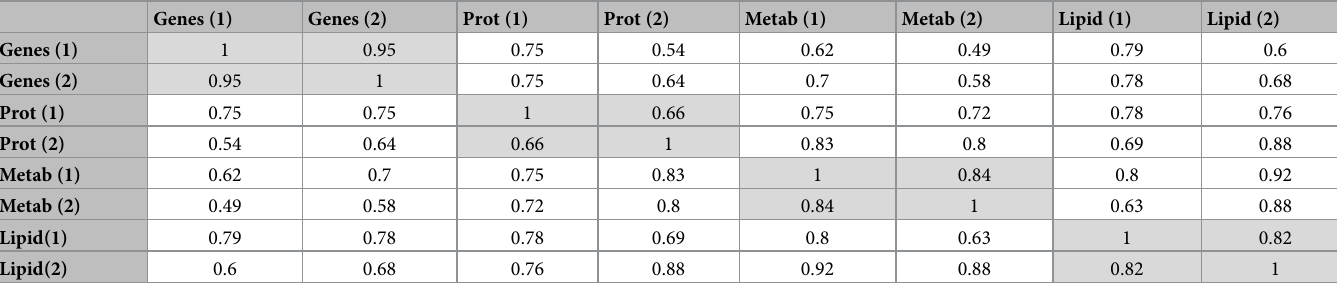
Table 21. Pairwise correlations of smCCA scores.